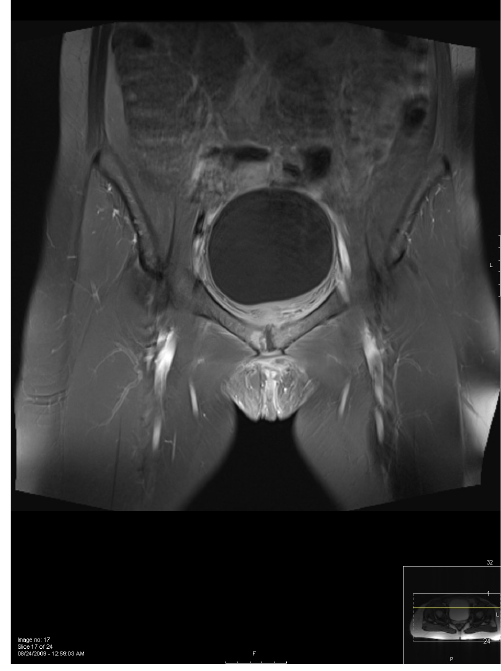
Figure. Axial T2 weighted image of the pelvis with fat saturation reveals bone marrow edema (white) on the right ischial spine just adjacent to the symphysis pubis suggesting osteomyelitis. Blood cultures grew Methicillin-sensitive Staphylococcus aureus and patient was treated with a prolonged course of intravenous ceftriaxone by the inpatient infectious disease team and